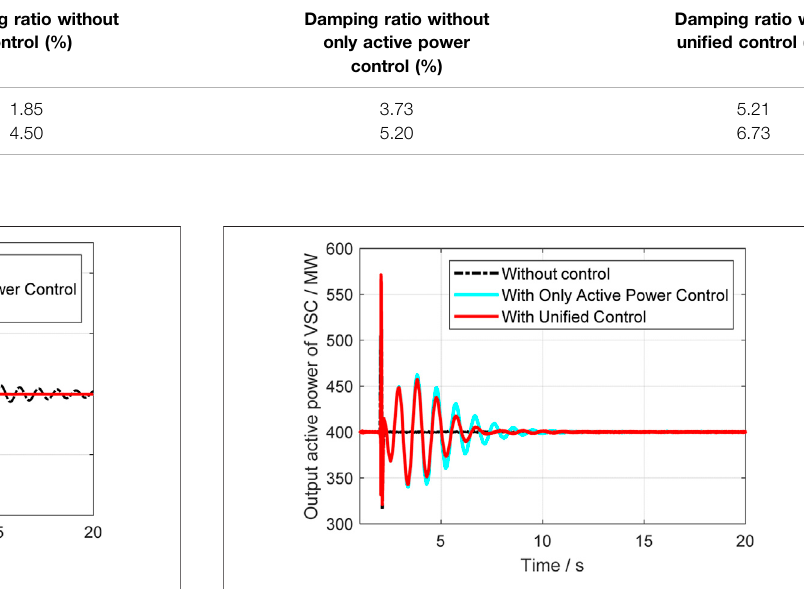
FIGURE 19 | Rotor speeds of G3 with different schemes.